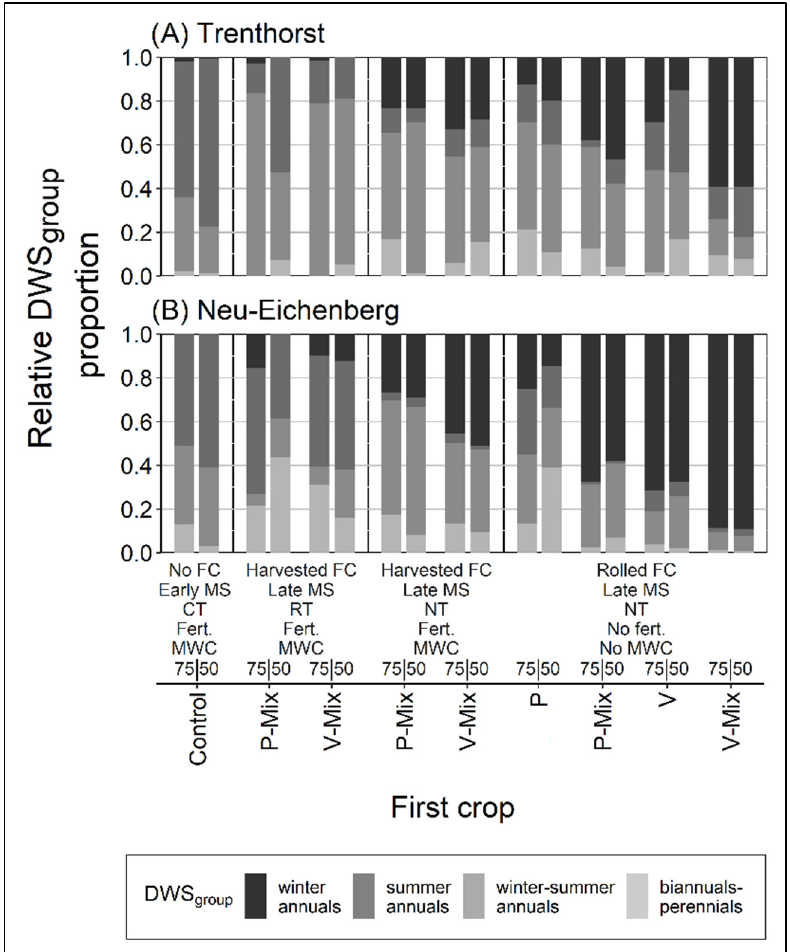
Figure 6. Relative proportion of dominant weed species groups (DWS group ) at the two locations averaged over year . The x-axis shows the first crop factor (P = winter pea, V = hairy vetch, P-Mix = winter pea and cereal mixture, V-Mix = hairy vetch and cereal mixture) grouped by management (FC = first crop, MS = maize sowing, CT = conventional tillage, RT = reduced tillage, NT = no tillage, Fert. = fertilization, MWC = mechanical weed control) and row width (75 cm and 50 cm). Colours indicate DWS group . Proportions were related to total DWS based on estimates. Additionally, DCS NT treatments were only present in the second year.